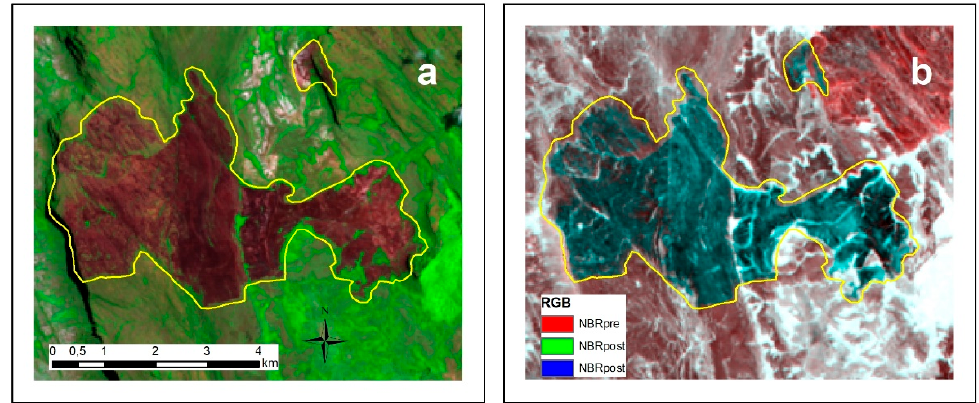
Figure 4. Pictures of: ( a ) colored composition image corresponding to the postfire image for the Gerais do Vieira fire, data from the Landsat-8 7-5-4 RGB OLI sensor and ( b ) multitemporal visualization of the burnt area related to the Gerais do Vieira fire, RGB NBRpre, NBRpost, and NBRregrowth.